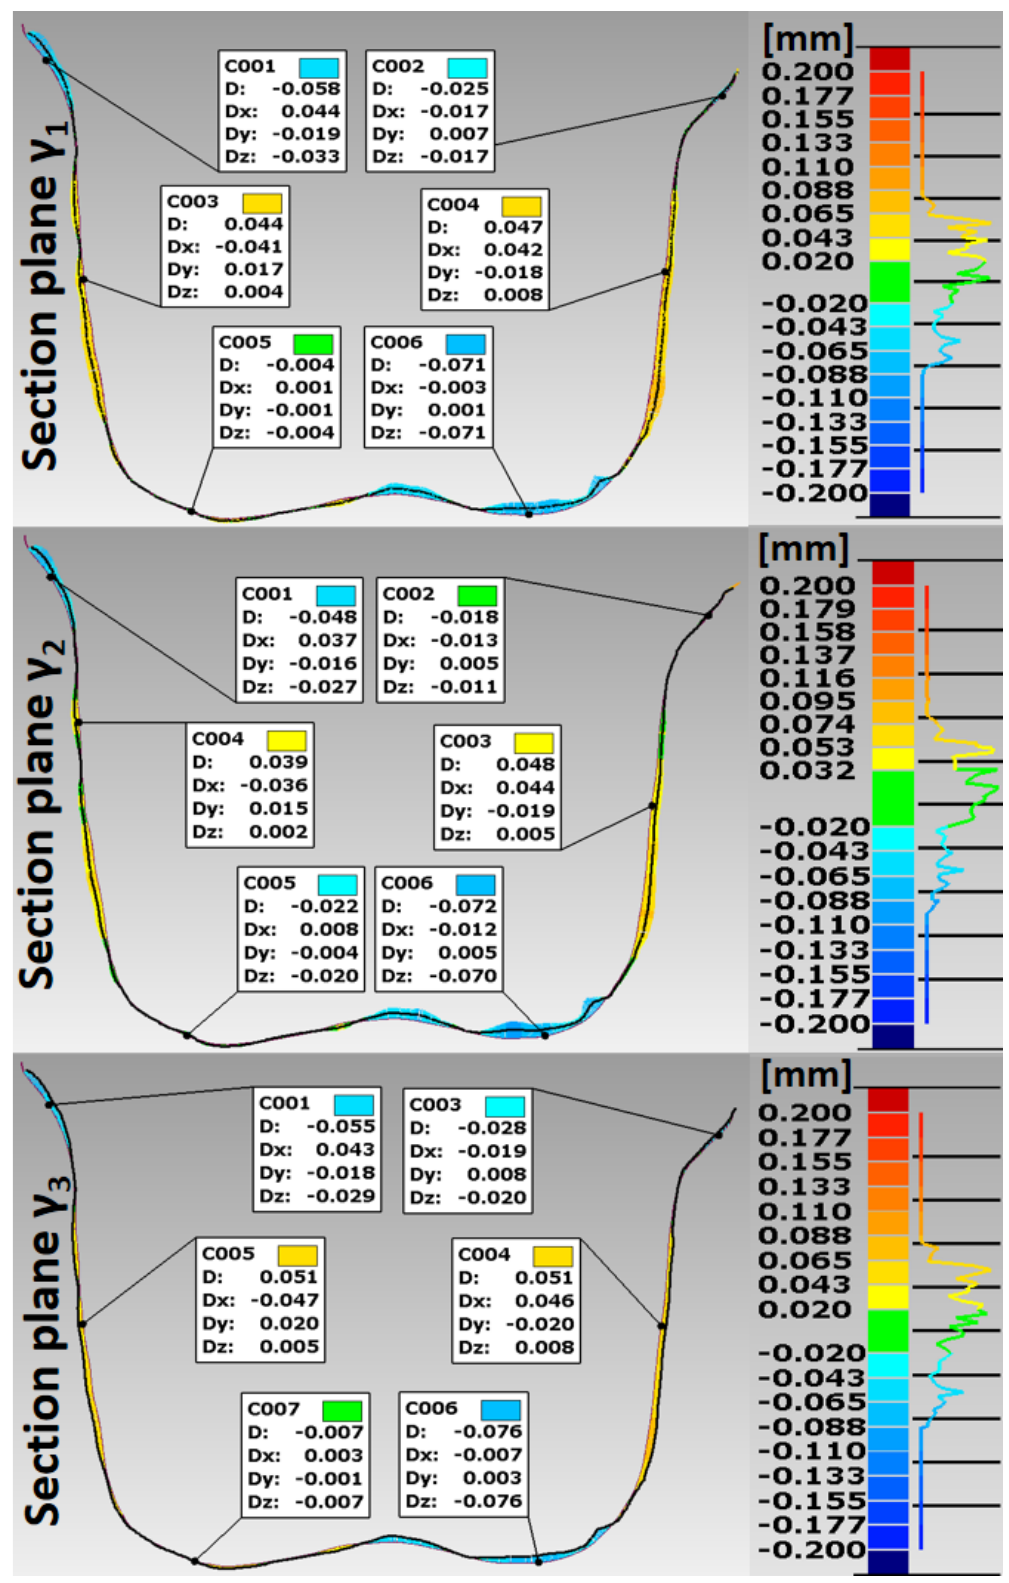
Figure 12. Distribution of deviations in the marginal and internal fit of a crown made of Ti6Al4V alloy in SLM for premolar 15.